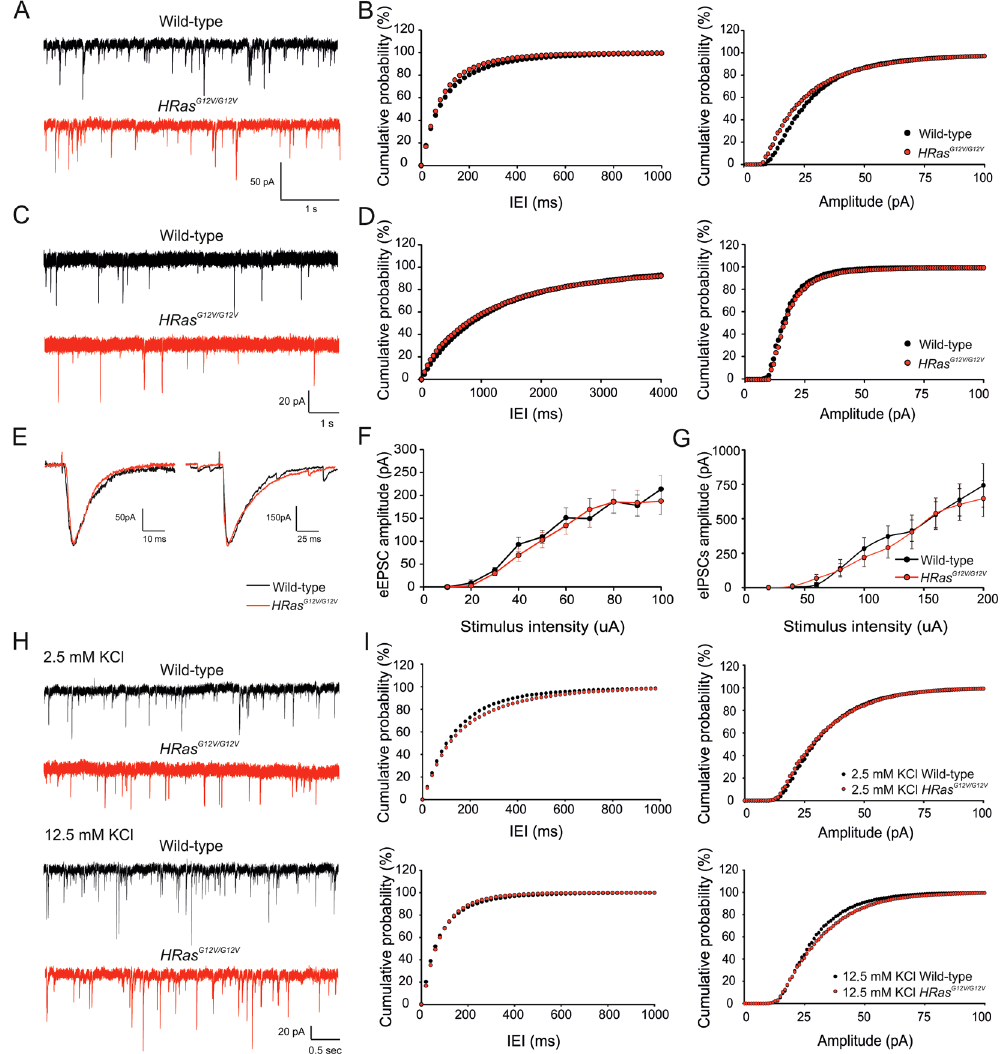
Figure 4. Normal baseline synaptic transmission in wild-type mice. ( A and C ) Representative traces of whole- cell patch-clamp recordings of spontaneous inhibitory (sIPSC) ( A ) and excitatory (sEPSC) ( C ) postsynaptic currents in acute hippocampal slices ( B , D ) Cumulative distribution of inter-event intervals (IEI; left panels) and amplitude (right panels) of sIPSCs and sEPSCs revealed no significant differences between the genotypes (sIPSCs: frequency: average: t 44 = − 0.39, P = 0.69, cumulative: P > 0.10; amplitude: average: t 44 = 0.38, P = 0.70, cumulative: P > 0.10; wild-type n = 28 cells/7mice, HRas G12V/G12V n = 26 cells/5 mice) (sEPSCs: frequency: average: t 44 = − 0.32, P = 0.75, cumulative: P > 0.10; amplitude: average: t 44 = 0.67, P = 0.50, cumulative: P > 0.10; wild-type n = 20 cells/5 mice, HRas G12V/G12V n = 26 cells/7 mice). Statistics: two-tailed t-test and Kolmogorov–Smirnov test (K–S) for average and cumulative values, respectively. ( E – G ) Evoked IPSCs and EPSCs are not altered in HRas G12V/G12V mice. ( E ) Representative traces of evoked EPSC (left) and IPSC (right) of wild-type cells (black trace) and HRas G12V/G12V cell (red trace). ( F , G ) Input-output curve representing averaged eIPSCs (wild-type n = 18 cells/10 mice, HRas G12V/G12V n = 14 cells/8 mice; ( F ) and eEPSCs (wild-type n = 19 cells/9 mice, HRas G12V/G12V n = 20 cells/10 mice; G ) Data are presented as mean ± SEM. Statistical test: repeated measure ANOVA: eEPSCs: F 1,39 = 0.26, P = 0.61; eIPSCs: F 1,32 = 0.01, P = 0.95. ( H,I ) Representative traces of whole-cell patch-clamp recordings of miniature inhibitory postsynaptic currents (mIPSC) in 2.5 and 12.5 mM KCl. A significant increase in the average frequency between 2.5 and 12.5 mM KCl was observed ( F 1,49 = 22,28, P < 0.01) but not in amplitude ( F 1,49 = 1,21, P = 0.28) nor between genotypes (genotypes: frequency: F 1,49 = 1.07, P = 0.30, amplitude: F 1,49 = 0.56, P = 0.46; interaction genotype * KCl: frequency: F 1,49 = 0.38, P = 0.54, amplitude: F 1,49 = 0.98, P = 0.33). ( I ) Cumulative distributions of IEI (left panels) and amplitude (right panels) of mIPSCs under 2.5 mM (upper panel) and 12.5 mM KCl condition (lower panel) showing no differences between genotypes at both conditions (2.5 mM KCl frequency: P > 0.10; amplitude; P > 0.10; wild-type n = 14 cells/4 mice; HRas G12V/G12V n = 16 cells/5 mice) (12.5 mM KCl frequency: P > 0.10, amplitude: P > 0.10; wild- type n = 10 slices/3 mice, HRas G12V/G12V n = 13 slices/4 mice). Statistical test: two-way MANOVA and K–S (for average and cumulative values,